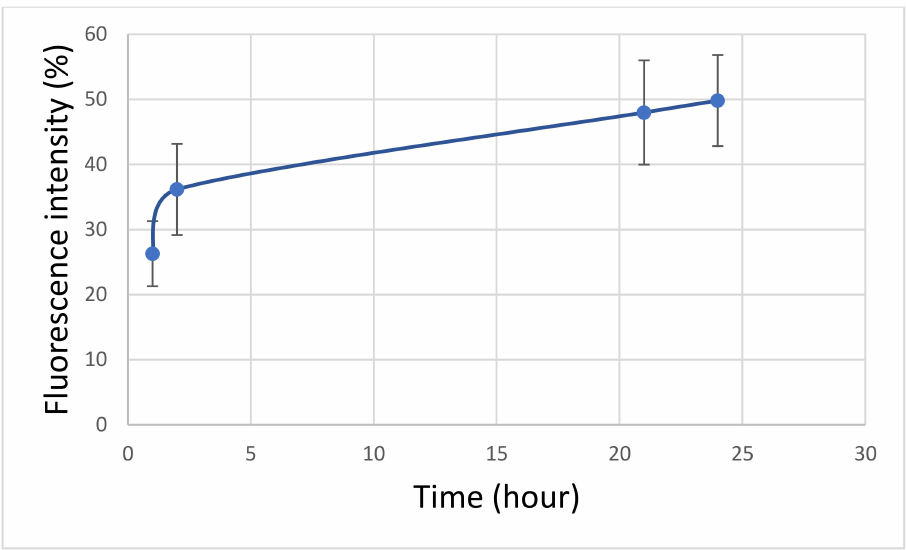
Figure 8. Bacteriophage release from CaCO 3 spherulites depending on the incubation